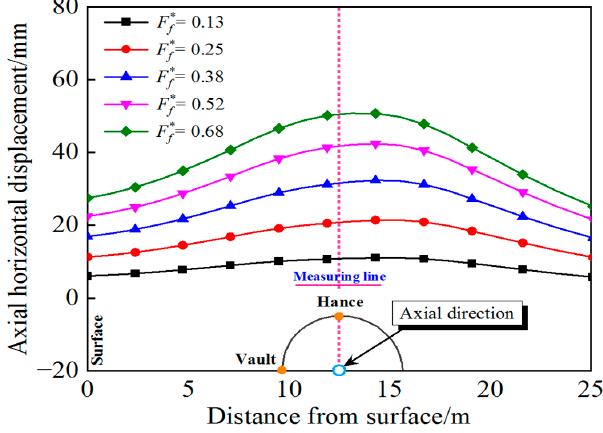
Figure 20. Horizontal deformation of the stratum along the axis direction under different friction coefficients F ∗ . f